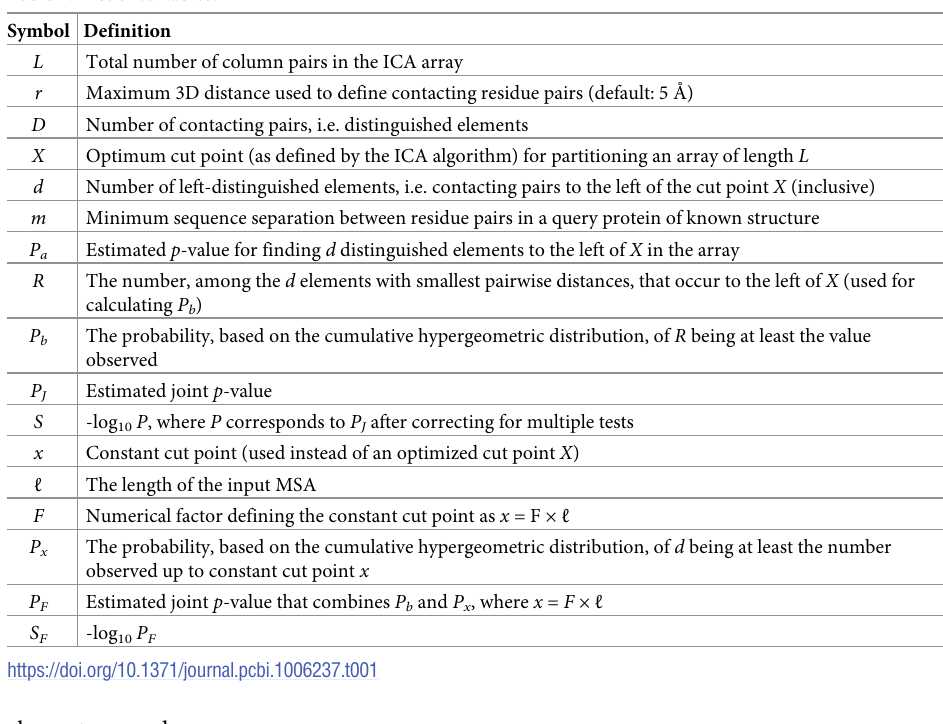
Table 1. List of variables. Symbol